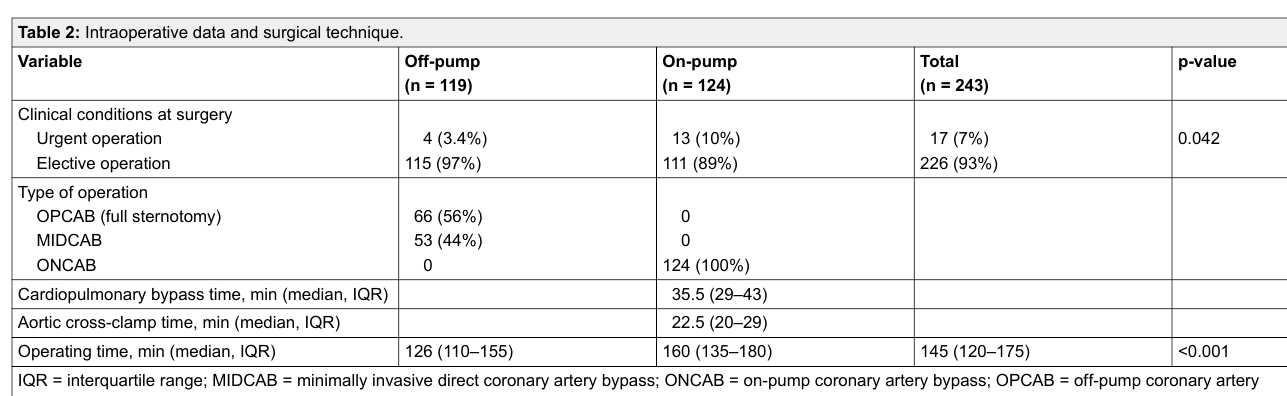
Table 2: Intraoperative data and surgical